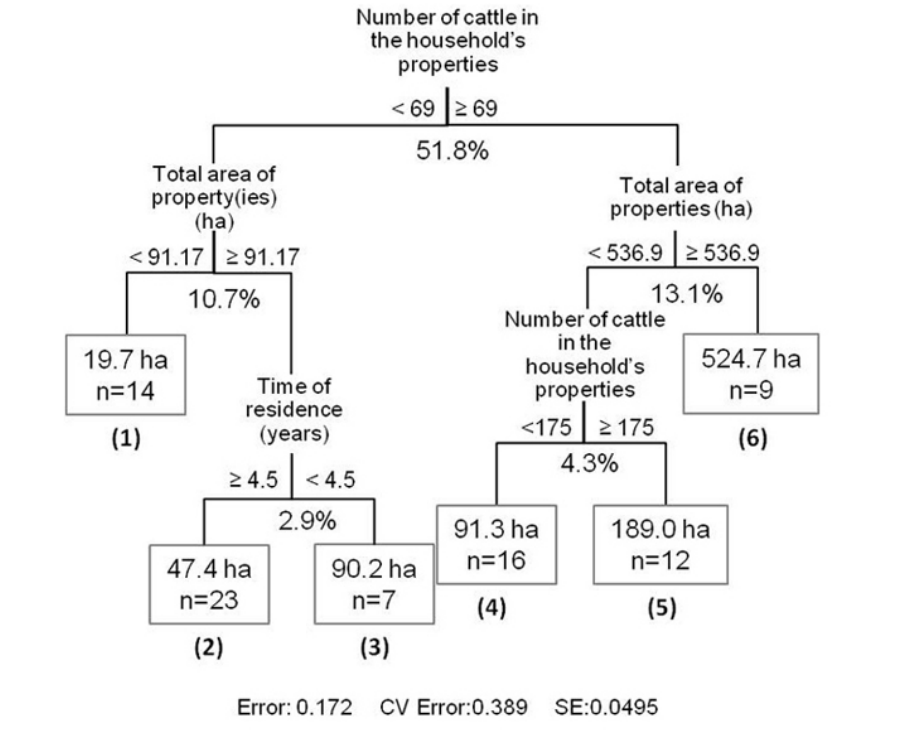
Fig. 6 . Regression tree with total deforestation in 2008 as the dependent variable. Values below the nodes represent the percentages of reduction of error, or how much of the variance of the data the division in question was able to explain. The values of the terminal leaves (1, 2, 3, 4, 5, and 6) represent the average area deforested and the number of sample units,